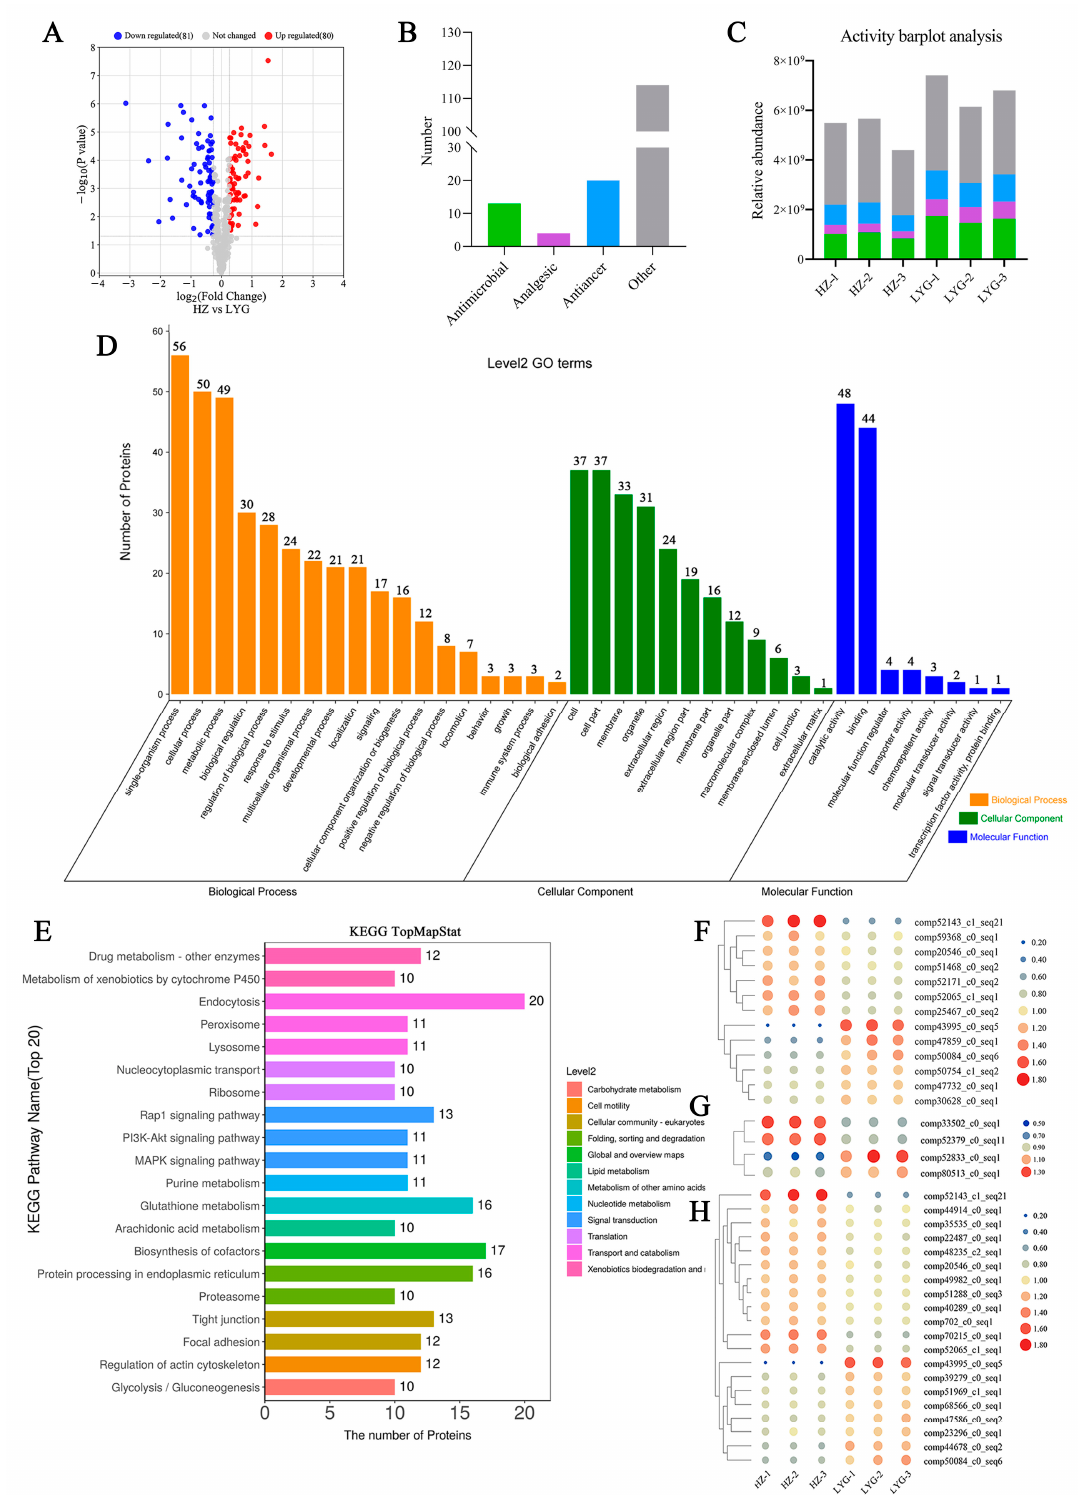
Figure 5. Functional protein analyses and screening for quality markers of extracellular differentially expressed proteins (eDEPs). ( A ) Volcano plot analysis. ( B ) Numbers of the three types of functional proteins among eDEPs. ( C ) Relative abundance analysis of the three types of functional proteins among eDEPs. ( D ) Statistical distribution of eDEPs under GO annotation. ( E ) KEGG pathway annotation statistical map of eDEPs (Top20). ( F – H ) Differential expression heat maps of antimicrobial, anti − inflammatory and analgesic, and antitumor active proteins, respectively.